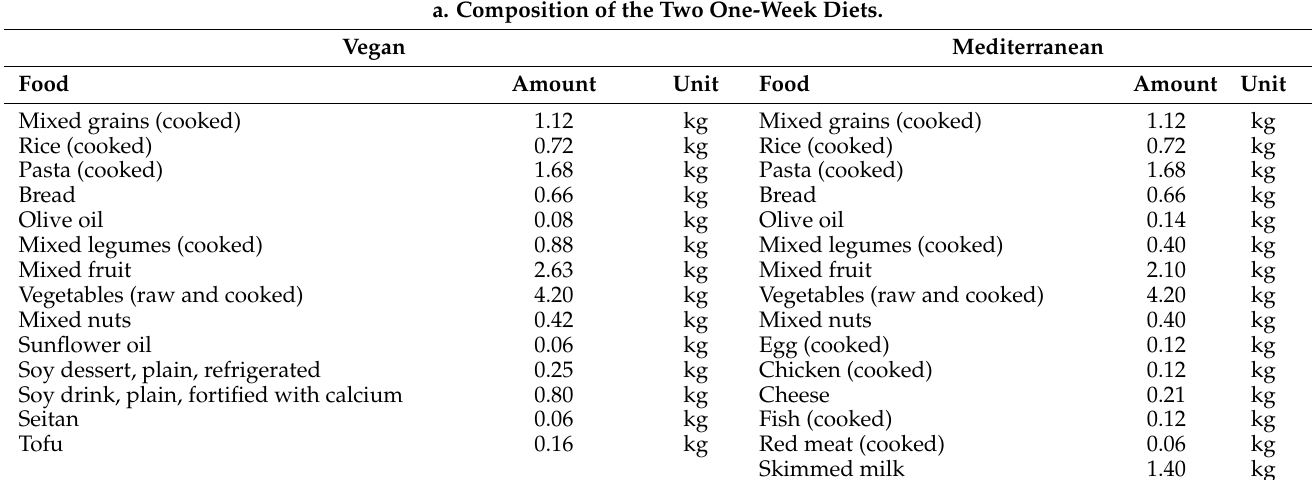
Table 1. Vegan vs. Mediterranean diet foods. a. Composition of the Two One-Week